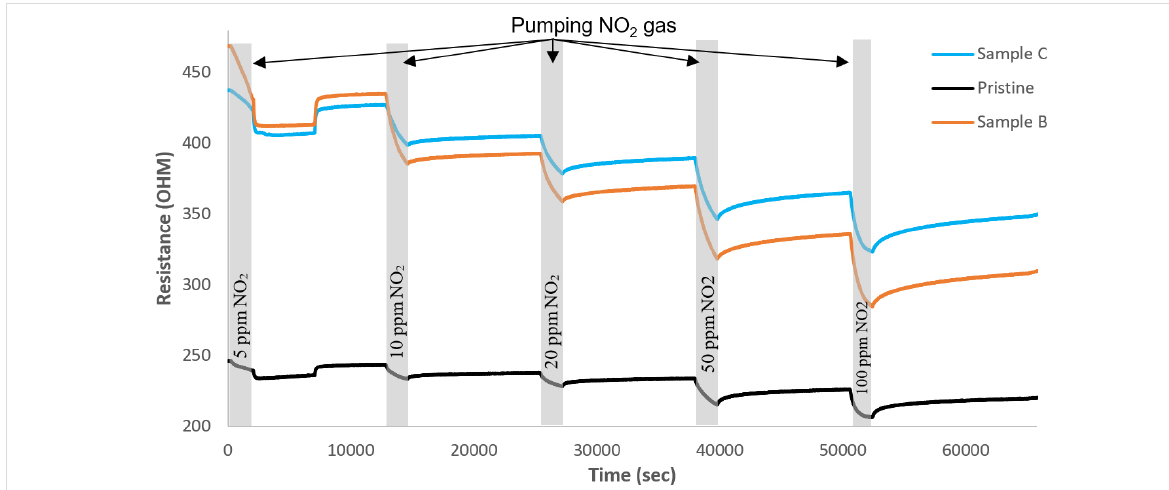
Figure 7: Electrical resistance of the samples as a function of time.